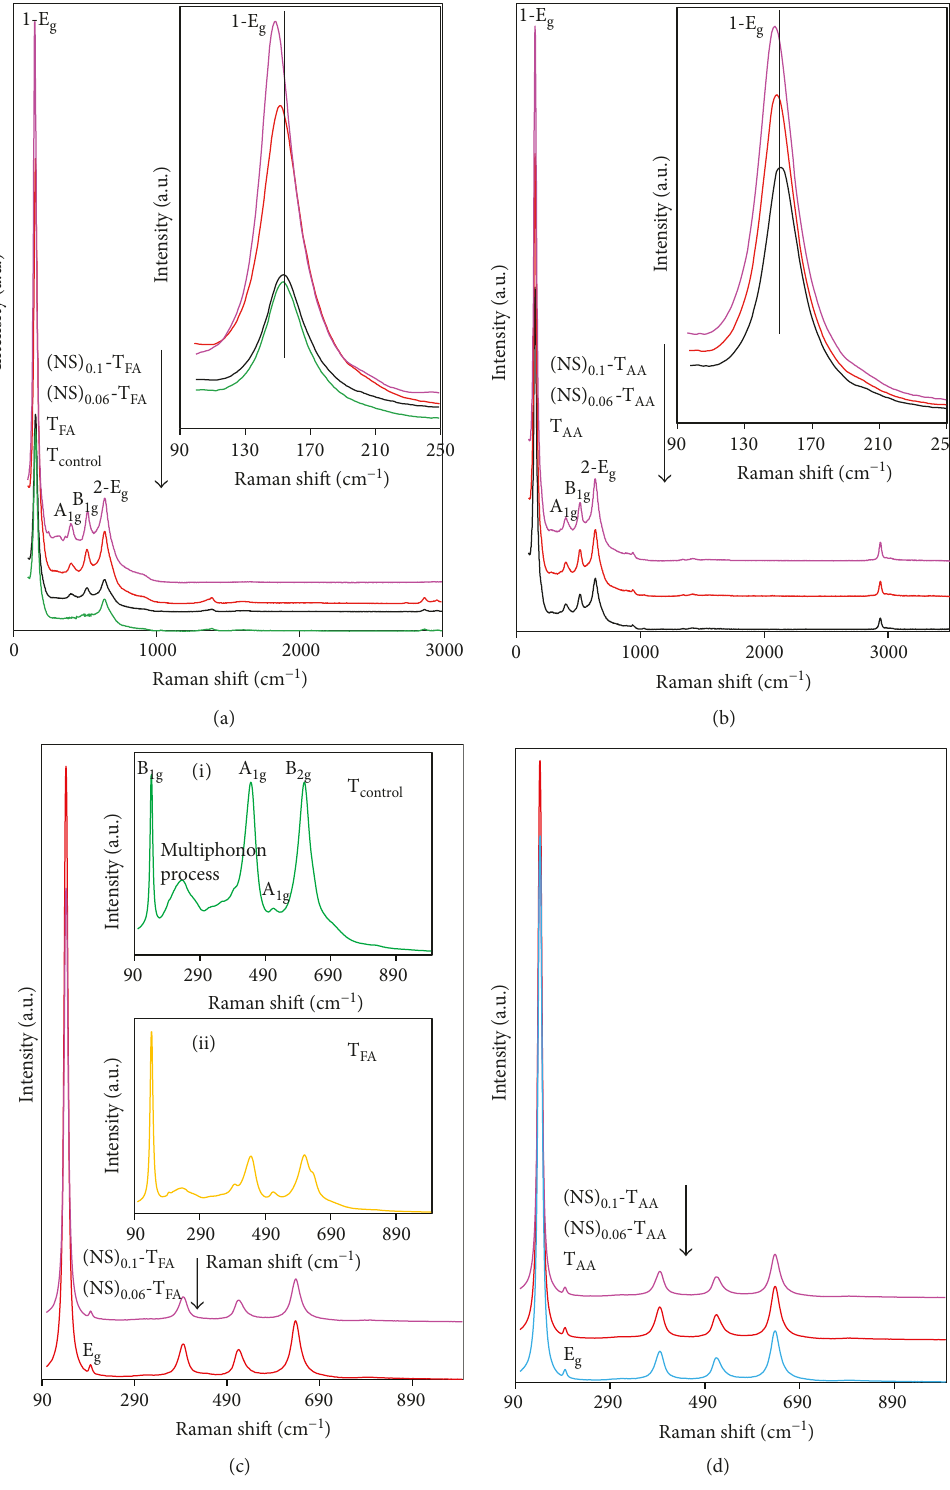
Figure 5: Raman spectra and 1-E mode shifting (insert) of precalcined powders (a) T g -T , and (NS) -T . Raman spectra of the powders calcined at 700 ° C (c) N (NS) 0.06 AA 0.1 AA (ii)) and (d) T , (NS) -T , and (NS) -T AA 0.06 AA 0.1 AA